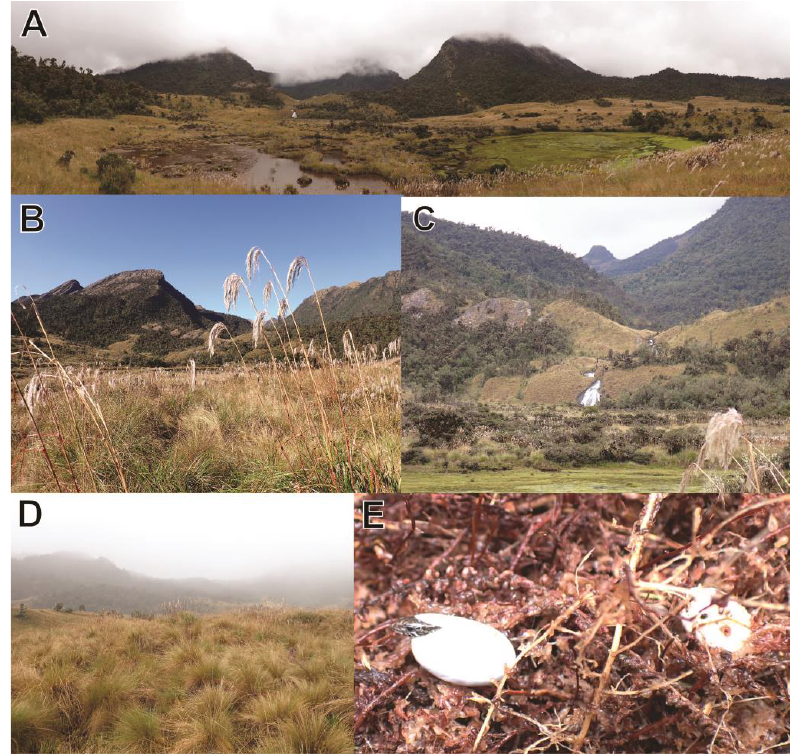
Figure 10. Habitat and natural history of Proctoporus titans sp. nov. ( A ): Panorama of the valley in southern view over the Pantano la Esperanza swamp toward the mountain ridge and swamp, taken 25 May 2022 at 11:44 AM. ( B ): western slope of the valley with Peruvian feathergrass in southeastern view taken from the campsite on 21 May 2022 at 8:22 AM. ( C ): Kitamarapó Waterfall in close aspect taken 25 May 2022 at 11:20 AM. ( D ): type locality of P. titans sp. nov. in western view taken on 17 May 2022 at 11:10 AM. ( E ): Hatchling (MUSM 40917) of P. titans sp. nov., taken on 17 May 2022 at 9:46 AM.